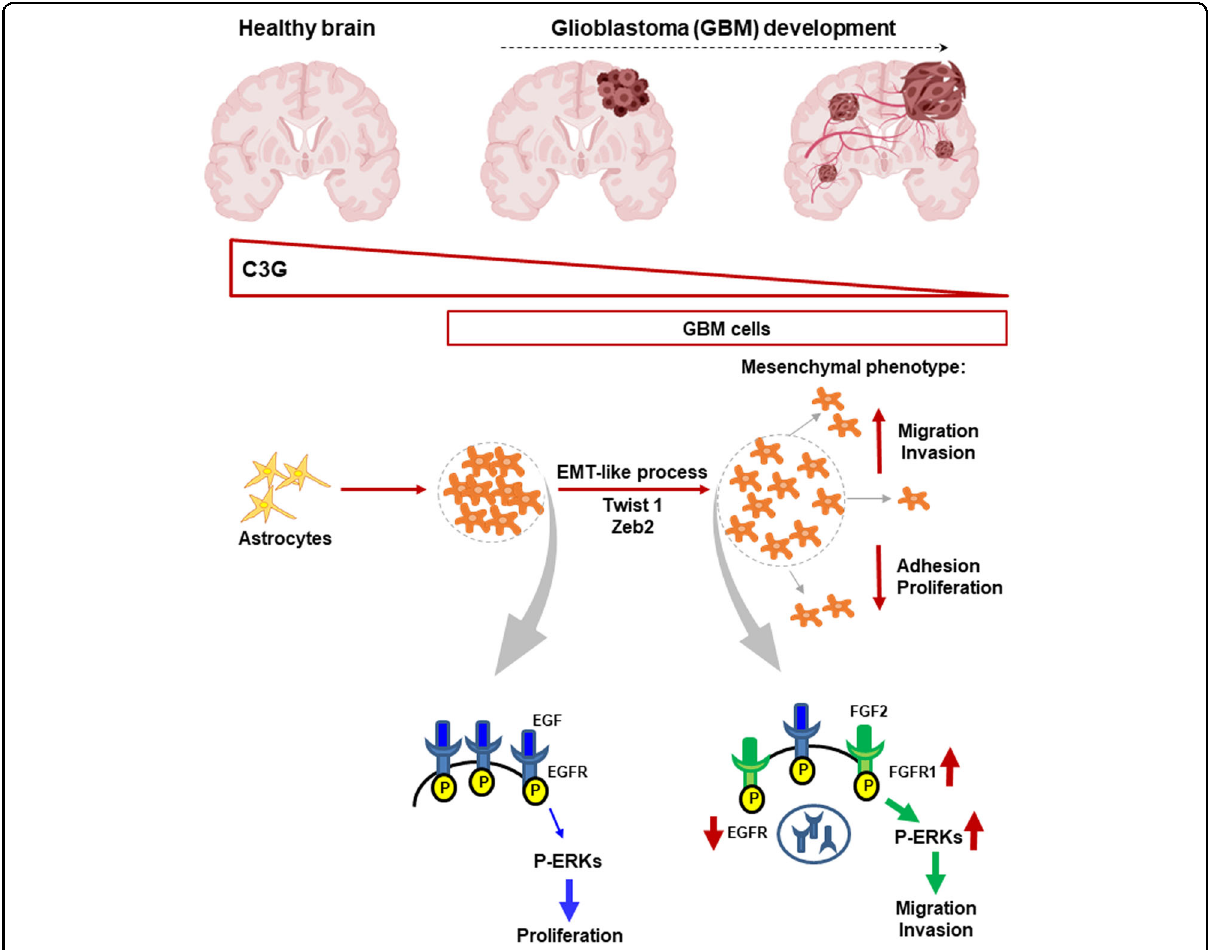
Fig. 8 Graphical abstract showing the function of C3G in glioblastoma. C3G levels are high in healthy brain and decrease in glioblastoma (GBM) cells and patient samples. This C3G downregulation enhances migration and invasion of GBM cells by mechanisms that depend on hyperactivation of RTKs such as FGFR1 acting through ERKs. In contrast, EGFR activity is down-regulated due to its low presence at the cell